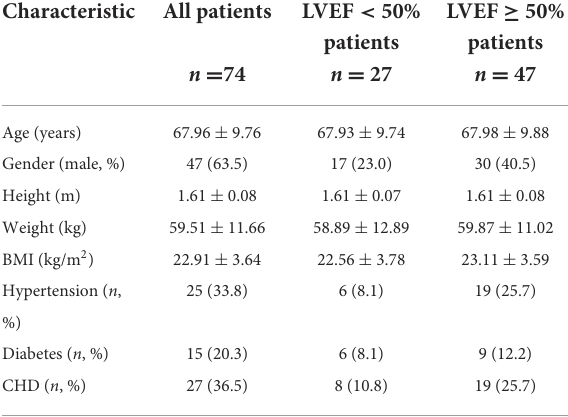
TABLE 2 The baseline characteristics between patients with LVEF < 50% and LVEF ≥ 50%. Characteristic All